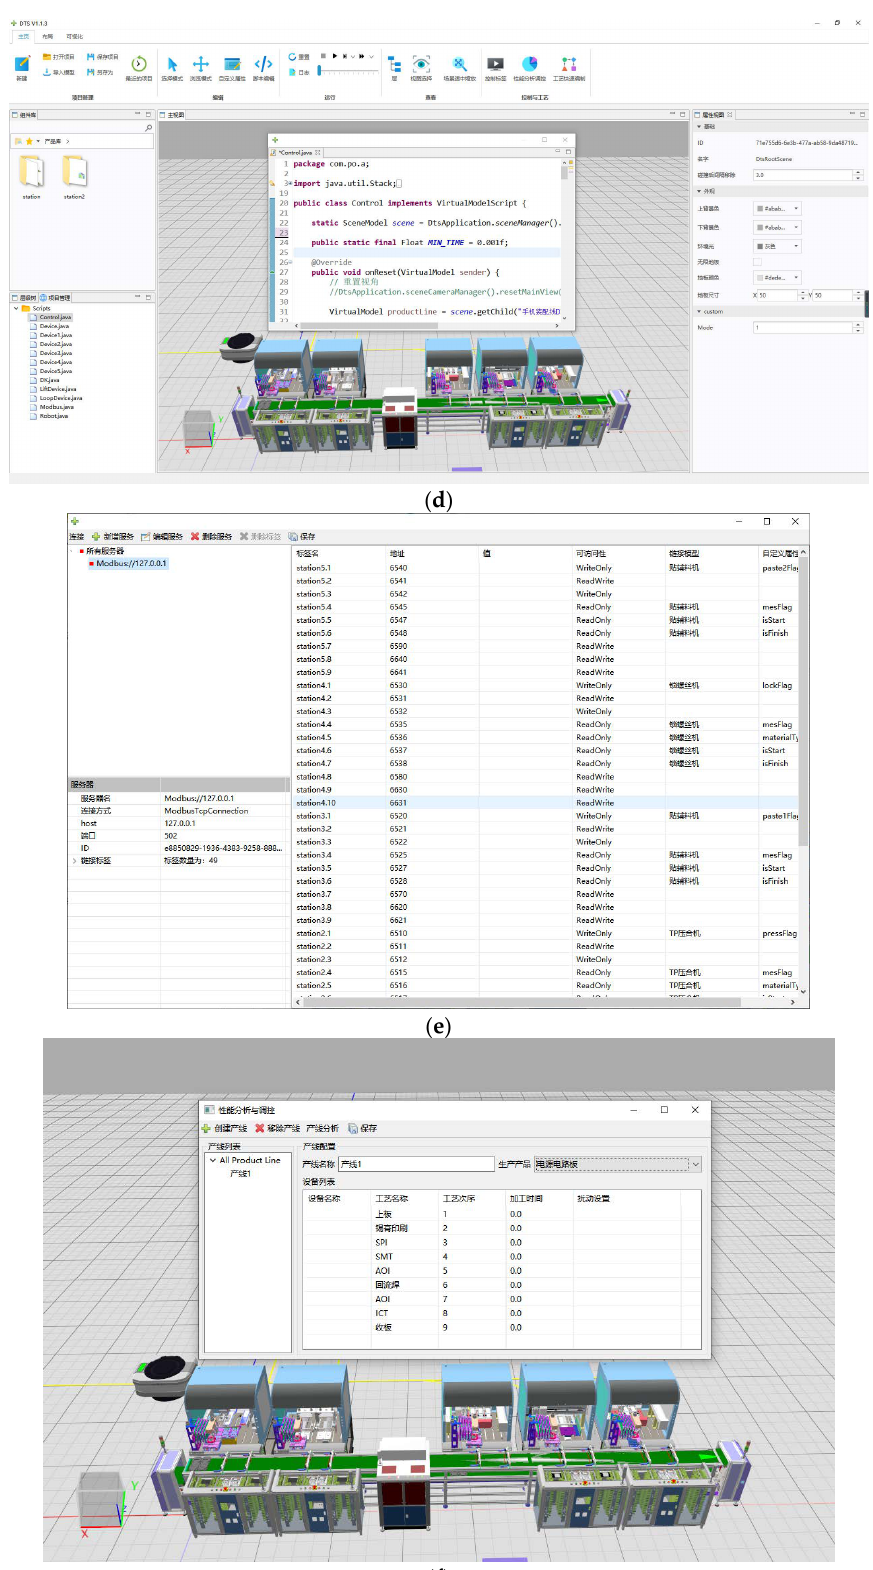
Figure 12. Introduction to the main function interface of DTS. ( a ) Digital twin interface. ( b ) Scene layout management interface. ( c ) Models’ property management interface. ( d ) Script writing interface. ( e ) PLC connection management interface. ( f ) Performance analysis and control